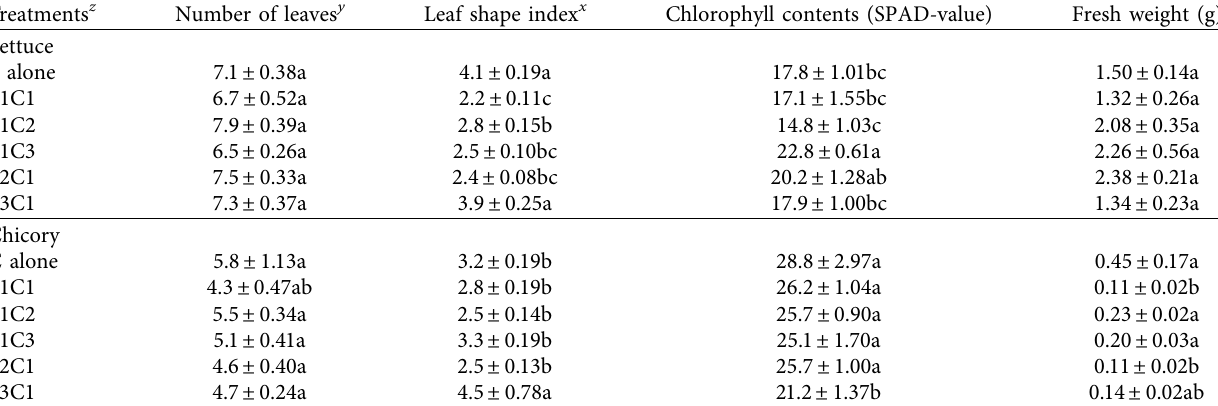
Means ± standard error within column followed by the same letter are not significantly different. L alone, lettuce 40 seeds; C1L1, chicory 20+lettuce 20; C1L2, chicory 13+lettuce 27; C1L3, chicory 10+lettuce 30; C2L1, chicory 27+lettuce 13; C3L1, chicory 30+lettuce 10; C alone, chicory 40 seeds. Data are means ± SE, the same letters are not significantly different within the same column according to Duncan’s multiple range test at p < 0 . 05 ( n � 9). Leaf shape index is leaf length/leaf width.